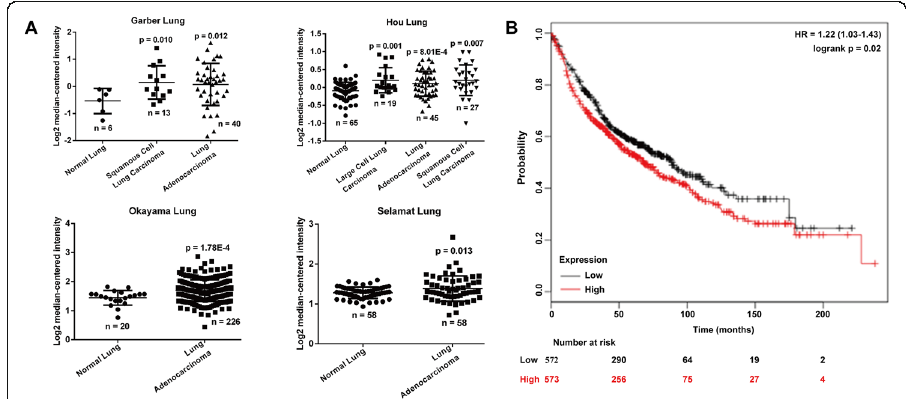
Fig. 1 RHBDD1 is overexpressed in lung cancer tissues and this correlates with a poor survival rate. a RHBDD1 gene analysis based on the Garber Lung, Hou Lung, Okayama Lung and Selamat Lung datasets from the Oncomine database. b The RHBDD1 gene in lung cancer. Kaplan-Meier plots showing overall survival in lung cancer. In red: patients with RHBDD1 expressions above the median. In black: patients with expressions below the median. The corresponding p -value is listed. HR: hazard ratio; CI: confidence interval; p value: log-rank test